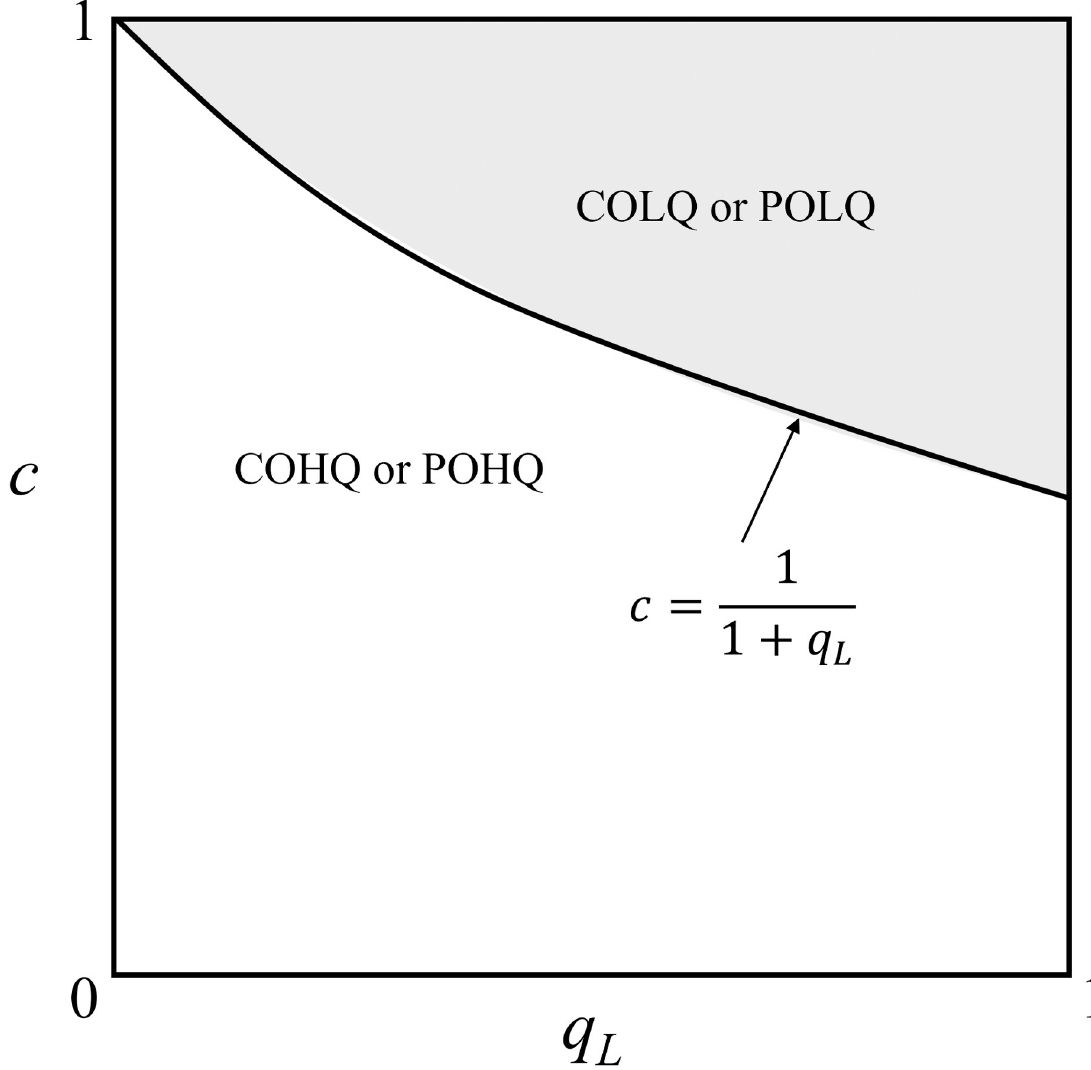
Fig 4. The influence of c and q on the maximal profit scenario of M 2 ( a = 1; α = 0.035; m = L